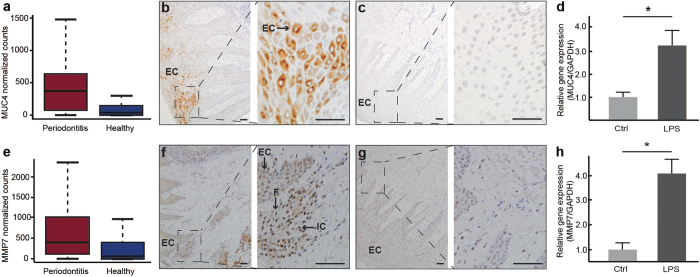
MUC4 and MMP7 mRNA and protein expression in gingival biopsies and gingival cells.(a) Boxplot demonstrating the normalized number of transcripts of MUC4 in gingival tissue from patients with periodontitis and healthy controls. (b) Representative staining for MUC4 in the gingival epithelium from a patient with periodontitis and (c) a healthy control subject. EC = epithelial cells. Scale bars = 50 μm. (d) Relative gene expression of MUC4 in gingival epithelial cells treated with lipopolysaccharide (LPS), for 24 hours, compared to control cells (Ctrl) treated with medium only, expressed as fold change normalized to the expression of GAPDH. Data are shown as mean ± S.D. from triplicates (*P < 0.001) (e) Normalized number of transcripts of MMP7 in gingival tissue from patients with periodontitis and healthy subjects. (f) Representative immunostaining for MMP7 in gingival tissue from a patient with periodontitis and (g) a healthy subject. EC = epithelial cells, IC = immune cells, F = fibroblast. Scale bars = 50 μm. (h) Relative gene expression of MMP7 in gingival fibroblast cells stimulated with lipopolysaccharide (LPS) (24 hours) compared to control cells treated with medium only (Ctrl), expressed as fold change normalized to the expression of GAPDH. Results shown are representative of three experiments performed in gingival fibroblasts obtained from three individuals and data presented as mean ± S.D. from triplicates (*P < 0.001).